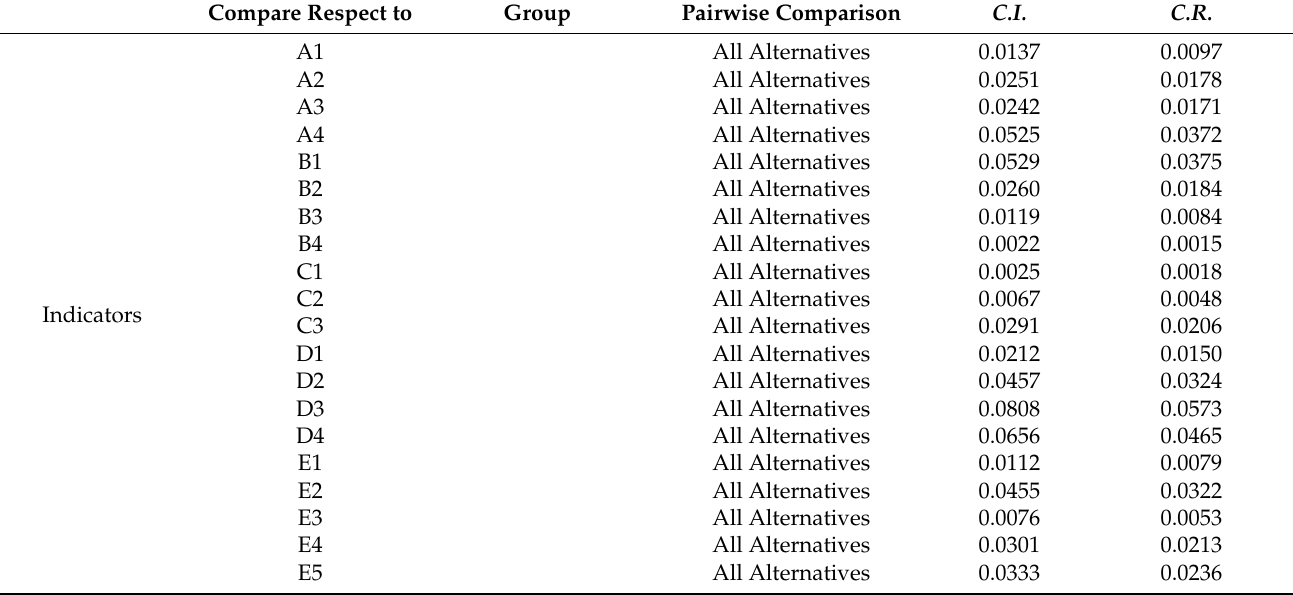
Table 11. C.I. and C.R values for all